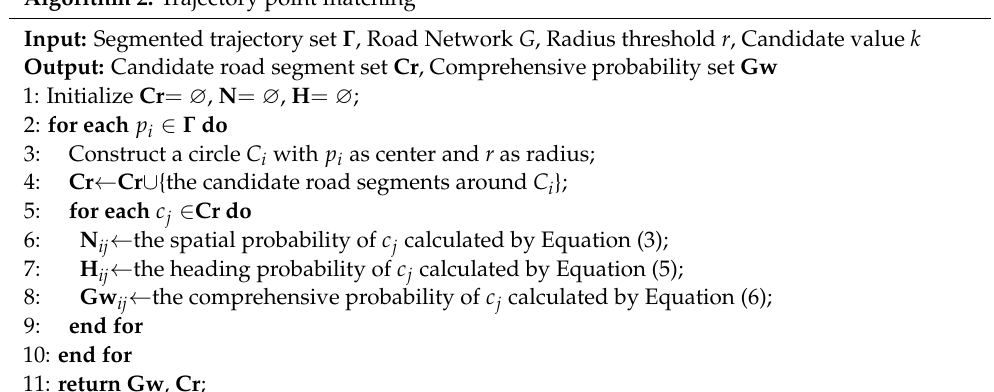
Algorithm 2: Trajectory point matching